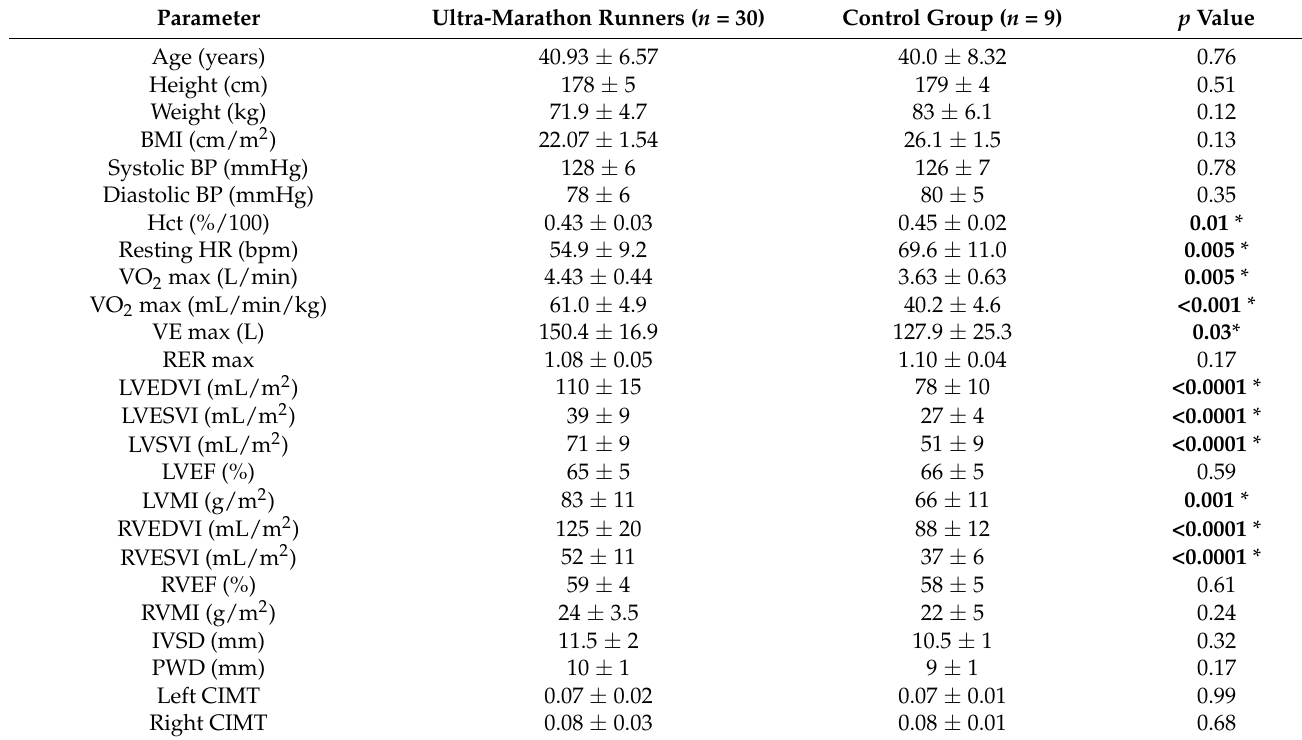
Table 2. Participants baseline characteristics and